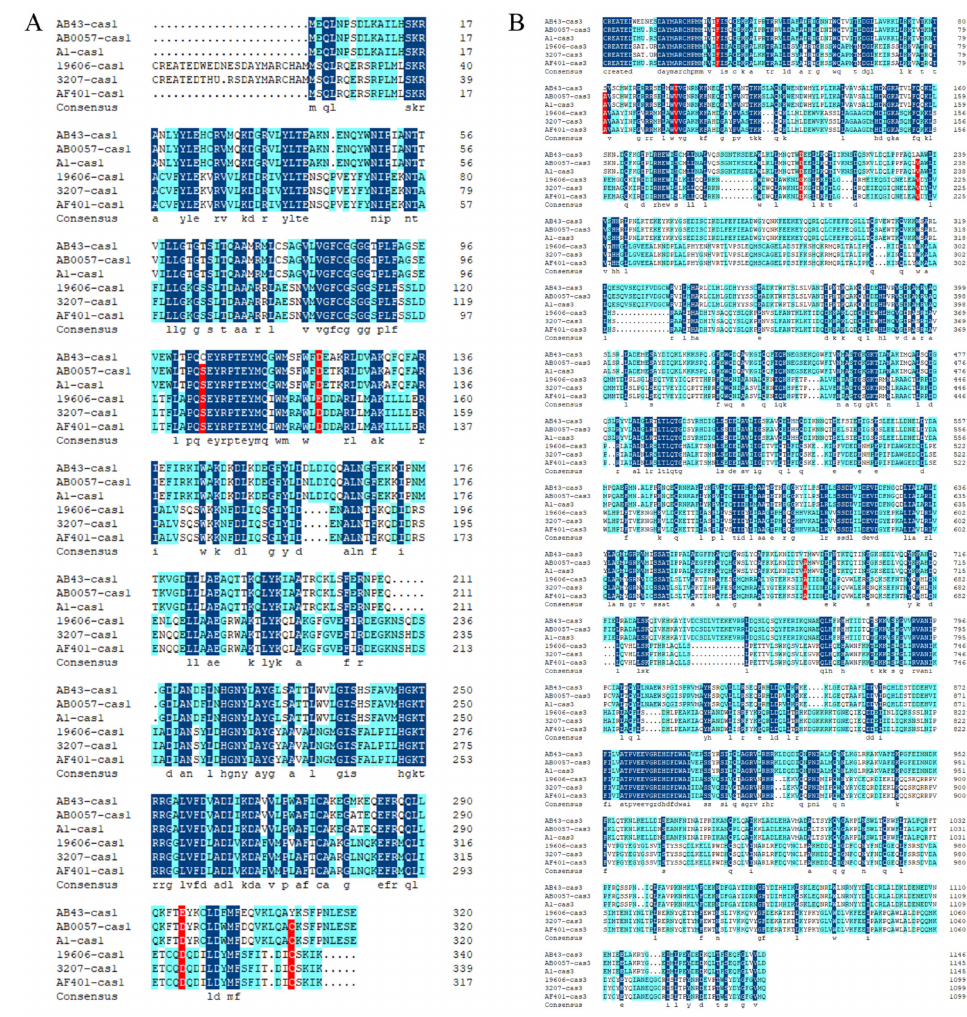
Figure 4. Alignment of Cas1 ( A ) and Cas3 ( B ) amino acid sequences of the Acinetobacter bauman- nii type I-Fb CRISPR-Cas system-containing strains (AB43, AB0057, R2091, 5075UW, AB307-0294, ATCC BAA1605, CIP70.10, AC1633, AYE, D36, AB0057, and A1) and type I-Fa CRISPR-Cas system- containing strains (ATCC19606, 3207, A1429, 103, 104, 736,7835, AB3207, DETAB-P2, B8300, and AF401). The “consensus” line represents the same amino acid with the reference sequence.